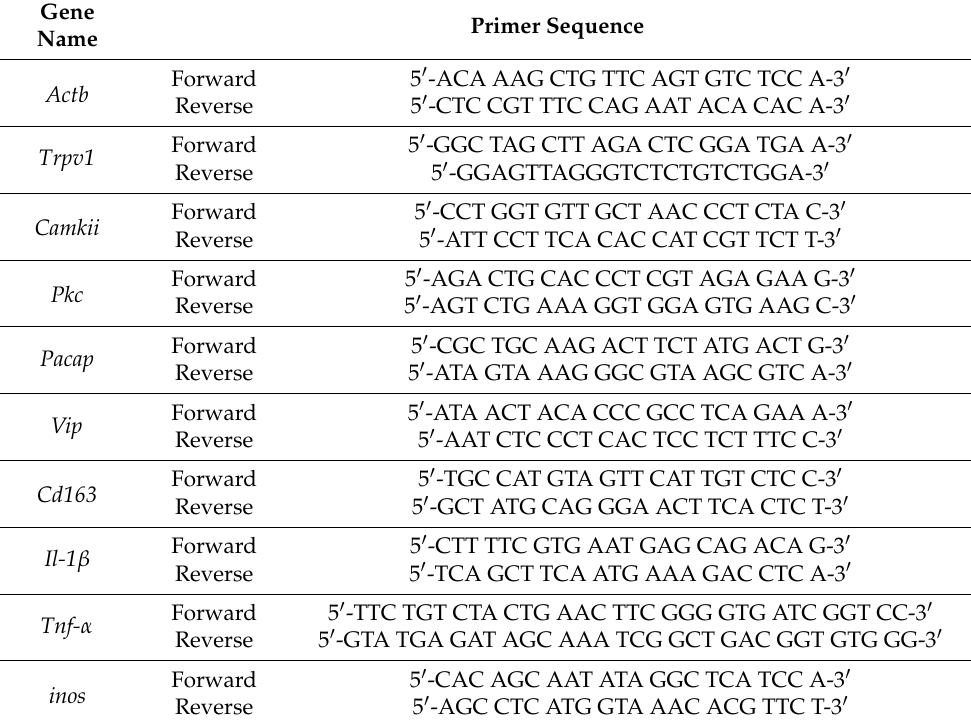
Table 1. List of primers for quantitative real time polymerase chain reaction (qRT-PCR).